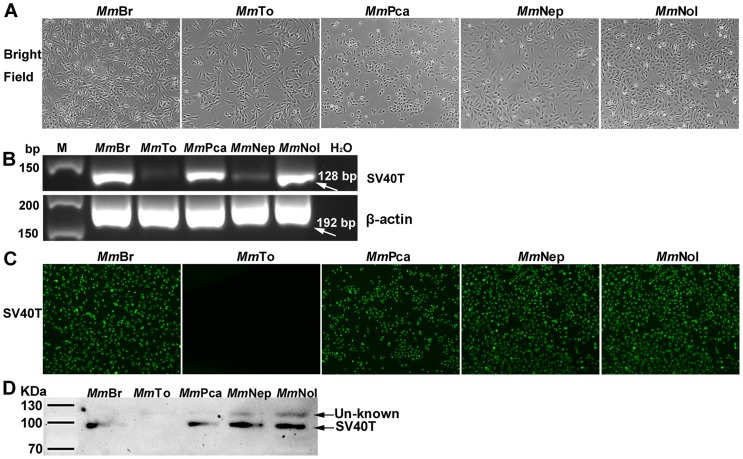
Newly established immortalized M. myotis cell lines from different tissues MmBr - brain; MmTo - tonsil; MmPca - peritoneal cavity; MmNep - nasal epithelium; MmNol - nervus olfactorius.(A) Morphology of a 24 h culture of immortalized M. myotis cell lines. (B) Expression of SV40T transcripts in different M. myotis cell lines. Note the very low expression in MmTo. (C) Expression of SV40T protein visualized by immunofluorescence and (D) by western blot using anti-SV40T monoclonal antibody. Note the absence of SV40T protein in MmTo cell line.